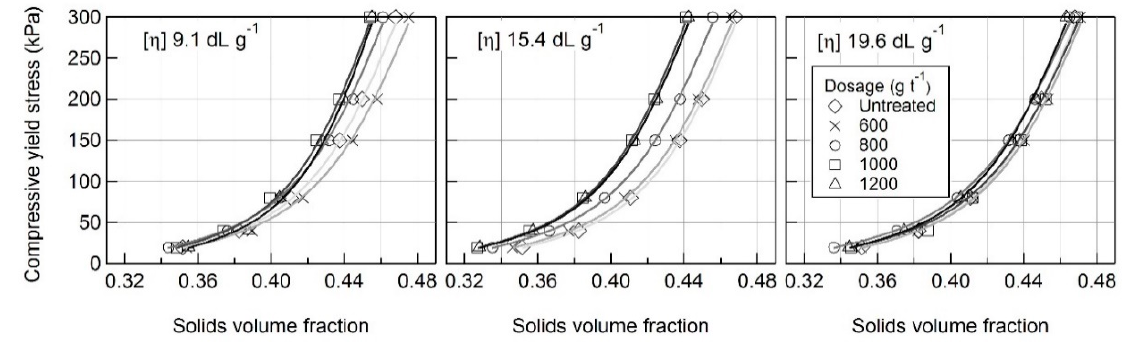
Figure 13. Compressive yield stress curves as a function of PAM [ η ] and dosage.